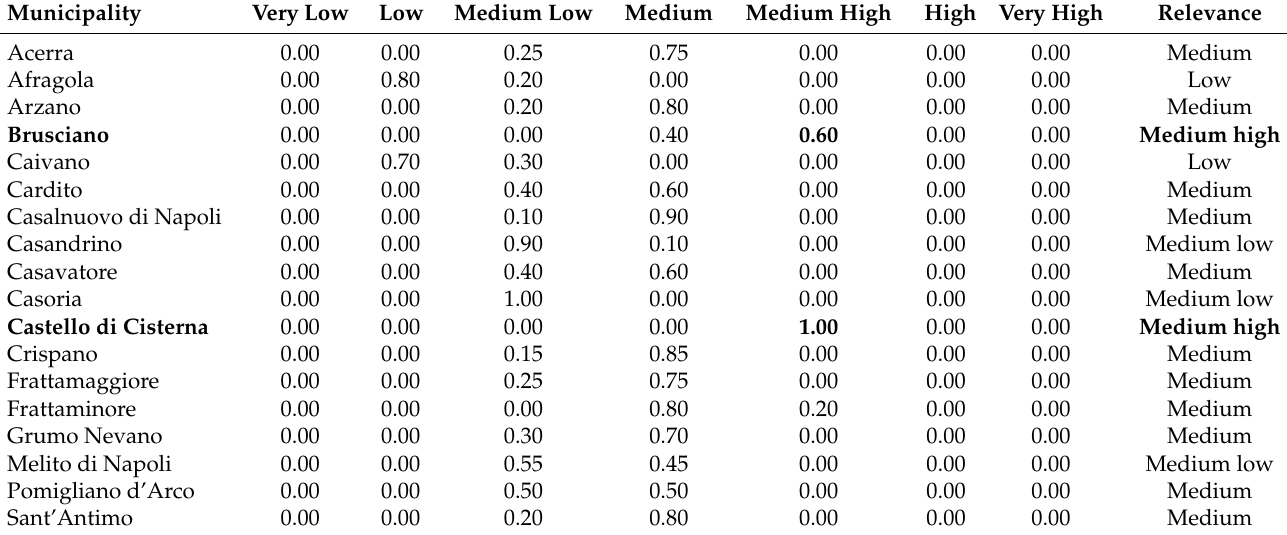
Table 6. Relevance of pleasant emotional categories in the year 2022.